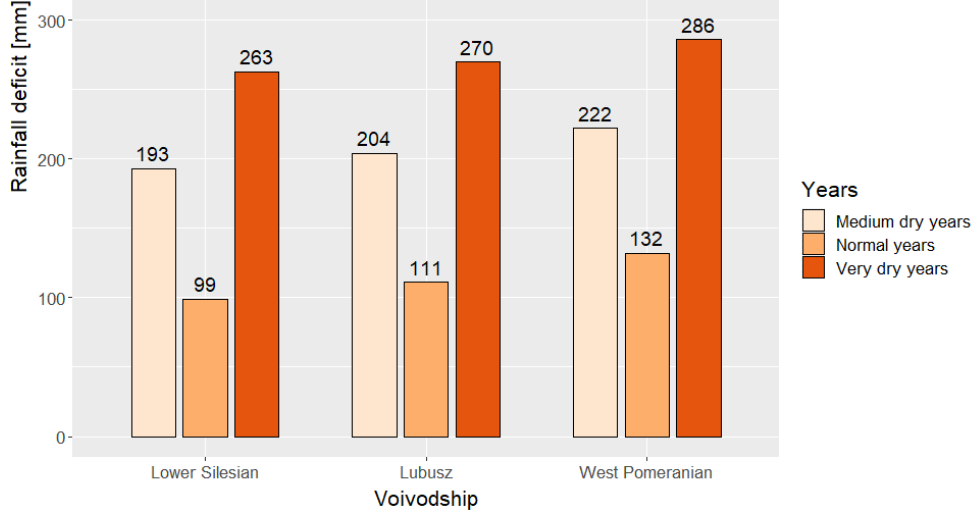
Figure 11. Rainfall deficit for willow cultivation in the analyzed provinces in 1981–2010.